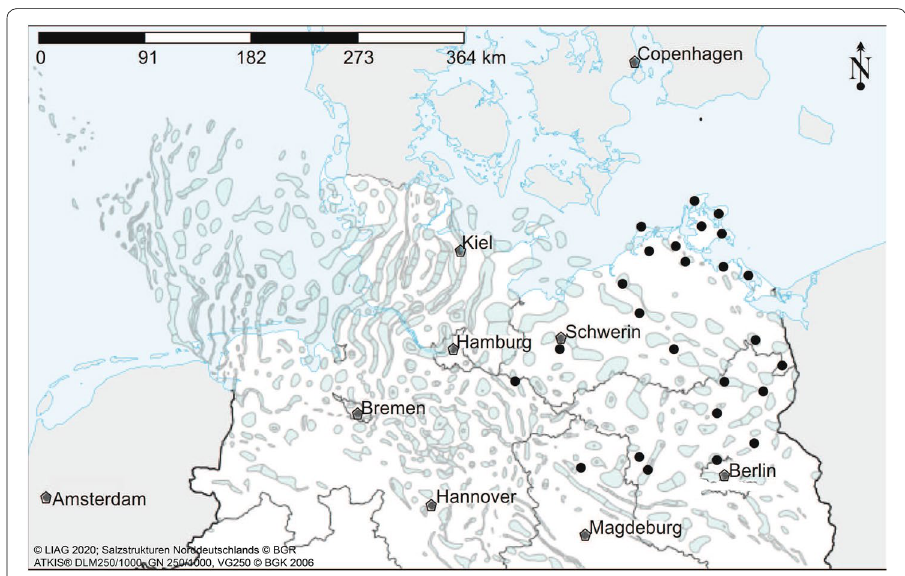
Fig. 2 Locations of the analysed wells. Black points: locations of the wells used for this study; grey pentagons: large cities; blue-green areas: halokinetic